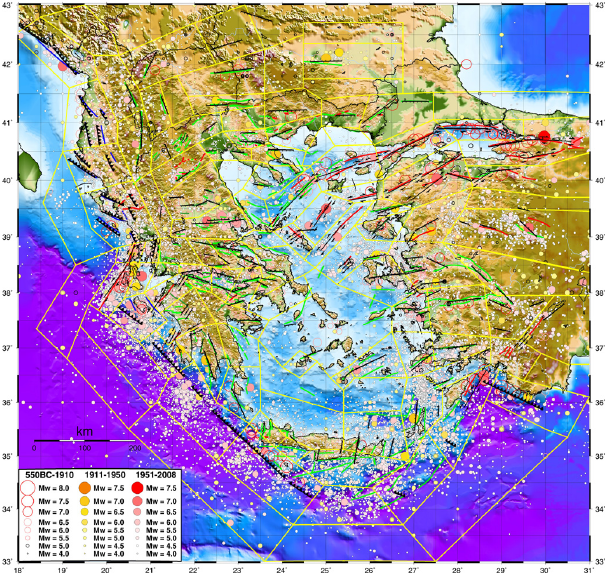
Figure 7. Map of the study area, with the 113 new seismic zones determined by the combined use of all available